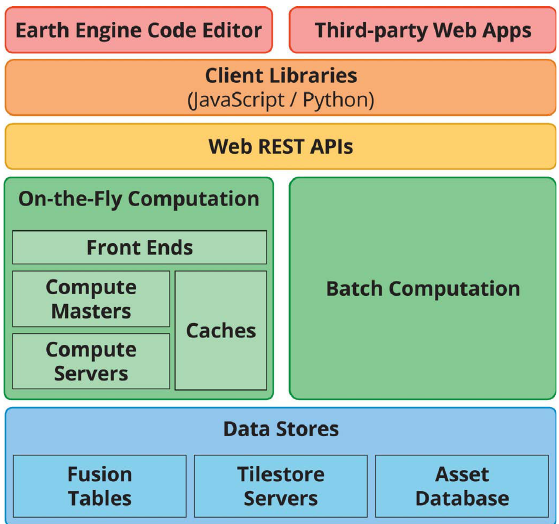
Figure 1. A simplified Google Earth Engine (GEE) system architecture diagram. Source: Gorelick et al.